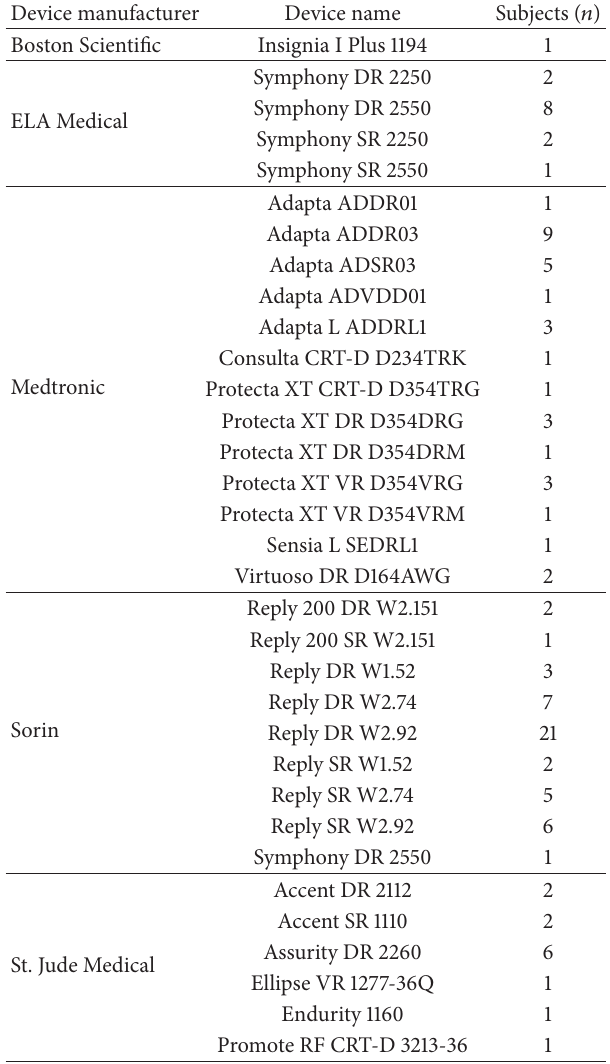
Table 2: Type and number of cardiac devices